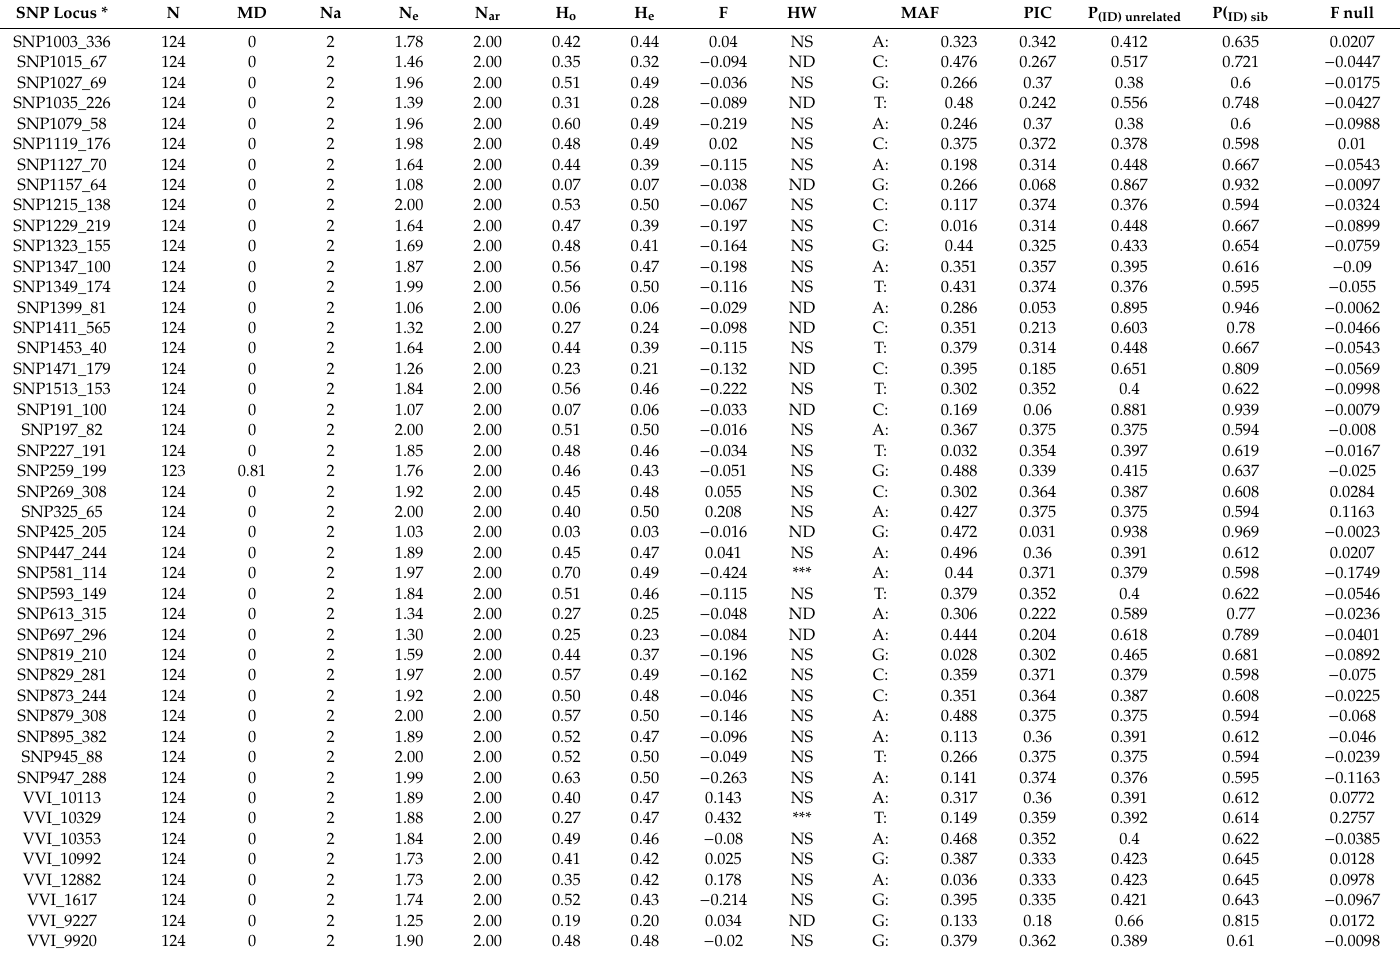
Table 3. Genetic diversity parameters assessed for 45 SNP loci in the subset of 124 unique accessions of the Croatian grape